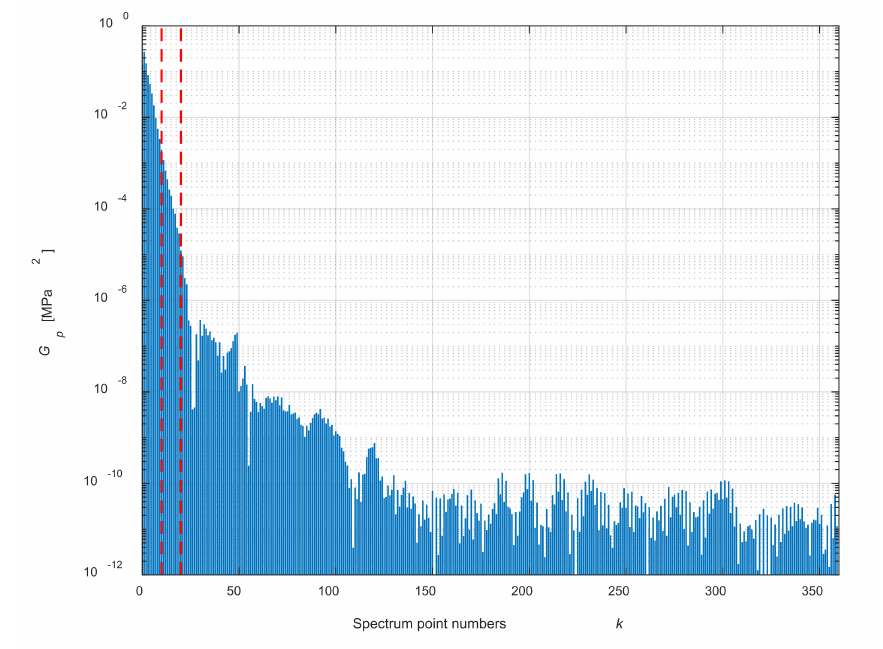
Figure 5. Averaged cycle power